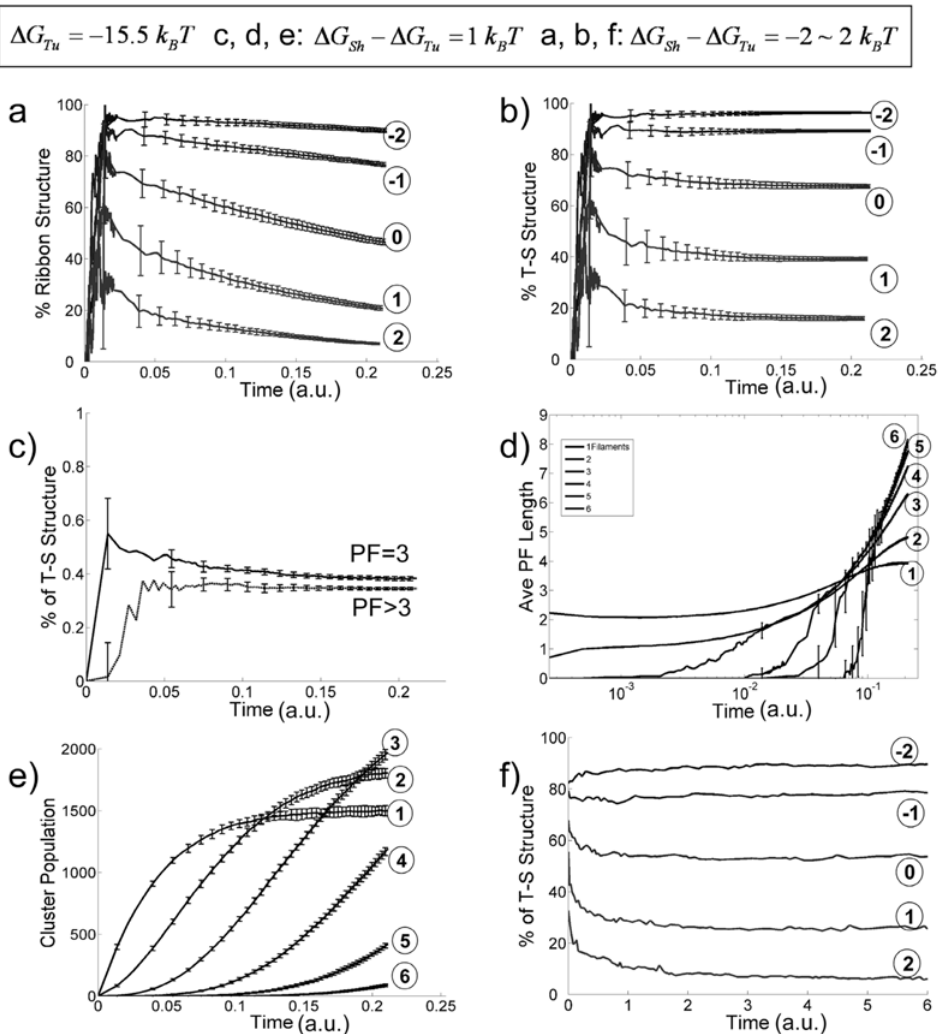
Figure 4. Effect of variable D G Sh {{ D G Tu (with fixed values of D G Tu ~~{{ 15 : 5 k B T and D G ShSh ~~ 6 k B T ) on the assembly process. (a)–(e) plot the simulation results with constant free dimer concentration and (f) plots the results with constant total dimers. (a) Percentage of ribbon structures v.s. time for different values of D G Sh { D G Tu ( { 2, { 1,0,1,2 k B T as labeled in the figure with corresponding circled numbers). (b) Probability of finding neighboring tube - sheet (T-S) structures as a function of time ( D G Sh { D G Tu ~{ 2, { 1,0,1,2 k B T as labeled in the figure with circled number). (c) Percentage of T-S structures v.s. time for structures with 3 PFs (solid line) and structures with 4 or more PFs (dashed line). (d) Average PF lengths of assembly structures v.s. time with number of PF=1, 2, 3, 4, 5, and 6, respectively (for D G Sh { D G Tu ~ 1 k B T ). (e) Occurrence of different size clusters v.s. time with numbers of PF=1, 2, 3, 4, 5 and 6, respectively ( D G Sh { D G Tu ~ 1 k B T for all). (f) Percentage of T-S structures v.s. time for variable D G Sh { D G Tu ( { 2, { 1,0,1,2 k B T , as labeled in the figure with corresponding circled numbers) with a constant number of total tubulin dimers of